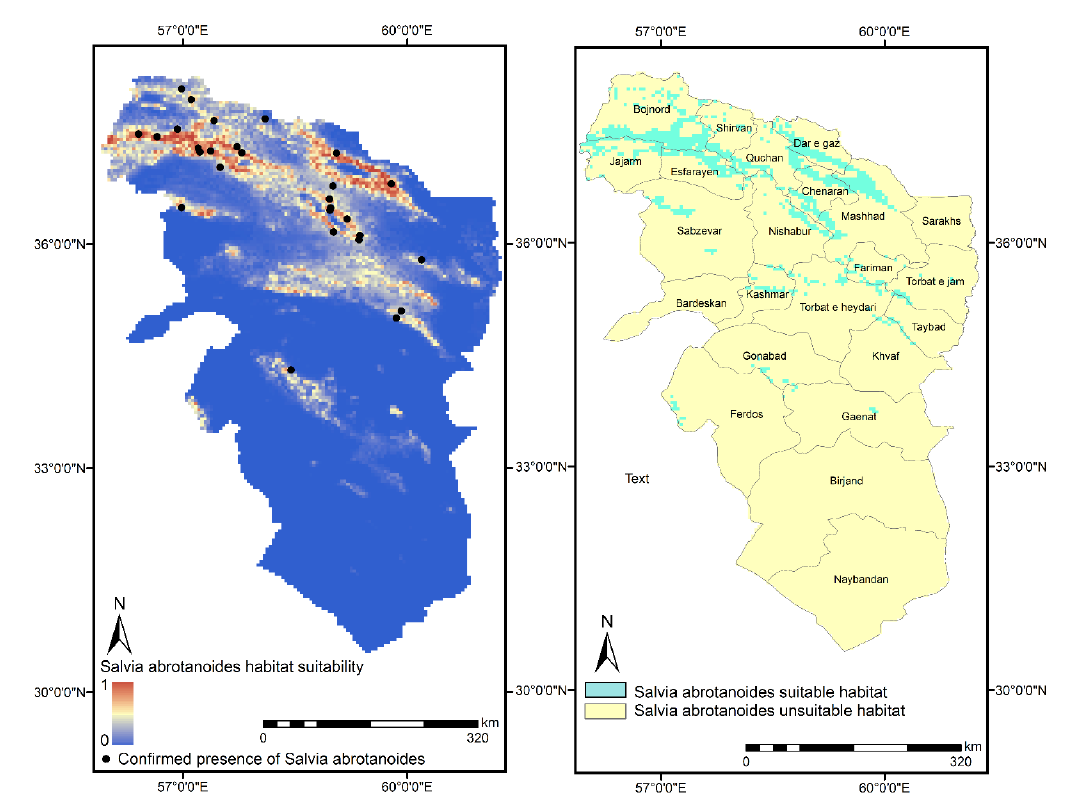
Fig. 9: Habitat suitability of Salvia abrotanoides and its suitable habitats in the cities of Khorasan